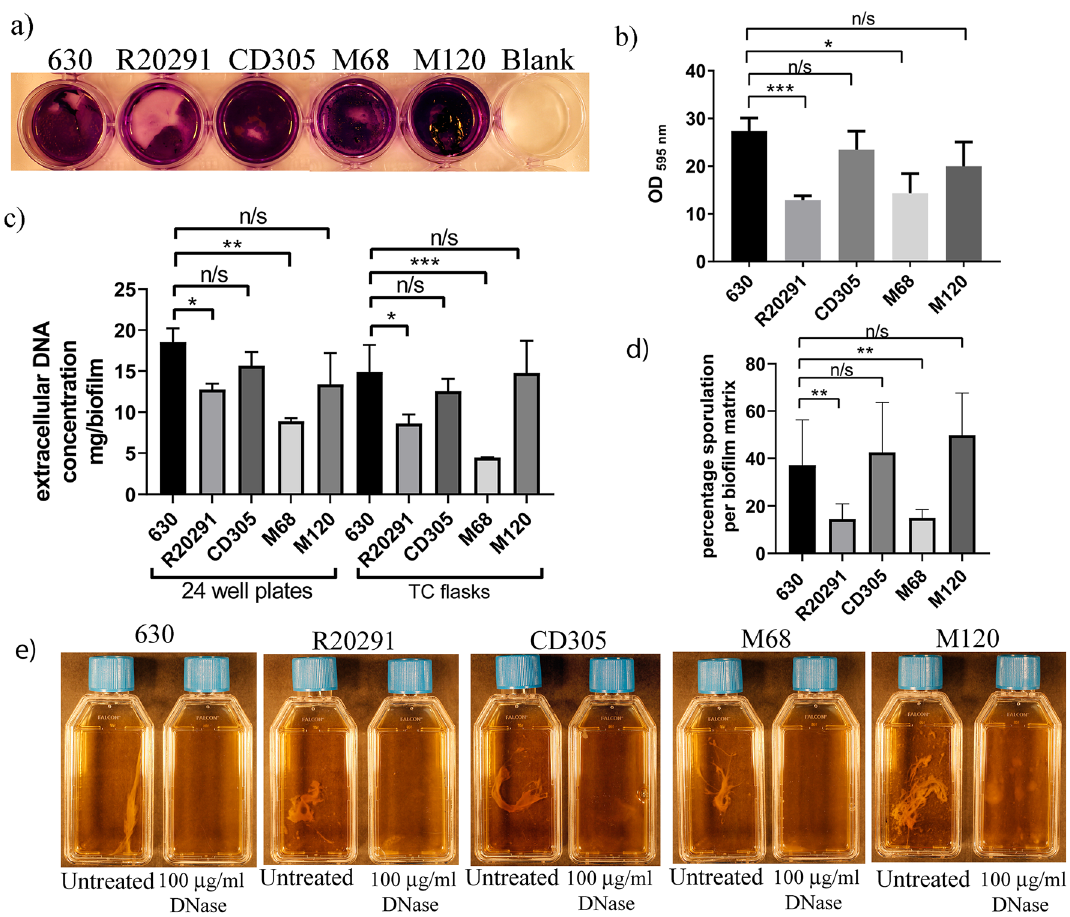
Figure 2. Biofilm formation and eDNA concentrations of representative strains from each of the five C. difficile lineages. ( a ) Biofilm biomass determined by crystal violet assays performed in 24-well plates. ( b ) Quantification of biofilm biomass by methanol extraction of crystal violet assays performed in 24-well plates. Crystal violet assays are representative of six independent biological replicates. ( c ) Concentration of eDNA ( C. difficile cells and spores were removed prior to eDNA quantification by filtering the vortexed disrupted biofilm samples) from duplicate biofilms produced in 24-well plates compared to TC flasks in a representative strain of all five C. difficile lineages: 630 (RT012), R20291 (RT027), CD305 (RT023), M68 (RT017) and M120 (RT078). ( d ) Percentage sporulation in the biofilm matrix produced in TC flasks for each strain in biological triplicates. ( e ) Duplicate late biofilm cultures were grown in tissue culture flasks, then detached by gentle agitation from the bottom of the tissue culture flask. One was left untreated and the other treated with 100 µg/mL DNase for 15 min to disrupt the biofilm matrix. Images of the tissue culture flasks were taken with a Cannon 600D SLR (mounted on a copy stand with lighting unit (Kaiser RS2) with a 50 mm prime lens). This was undertaken for C. difficile strains from all five lineages: 630 (RT012), R20291 (RT027), M120 (RT078), M68 (RT017) and CD305 (RT023). All error bars are SD. Statistical differences were assessed using linear regression analysis and significant differences are indicated *p < 0.05, **p < 0.01, ***p <